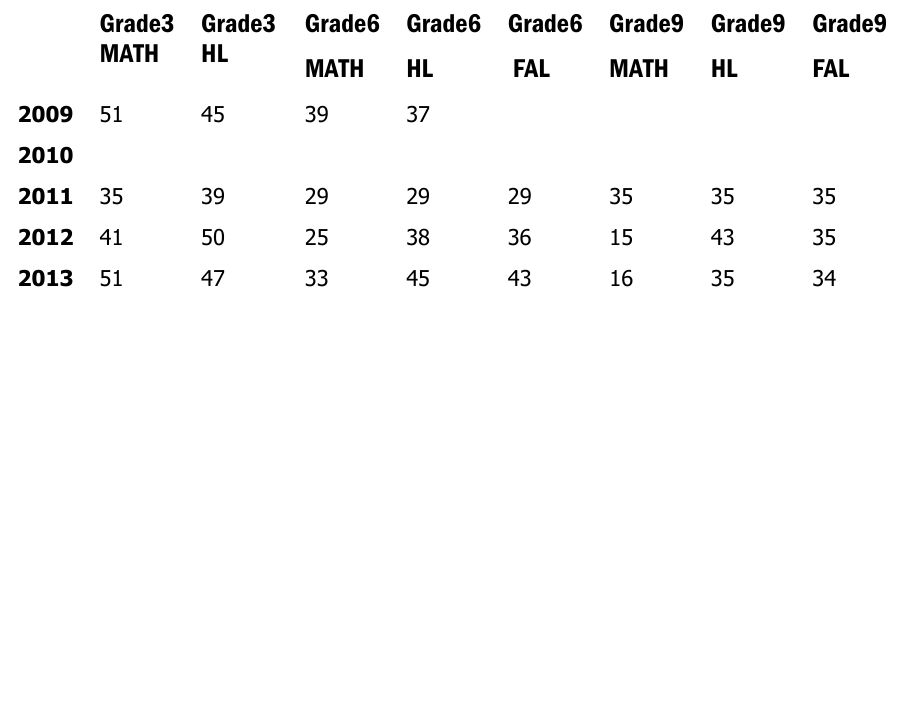
Table 3: Summary of Eastern Cape ANA’s average percent